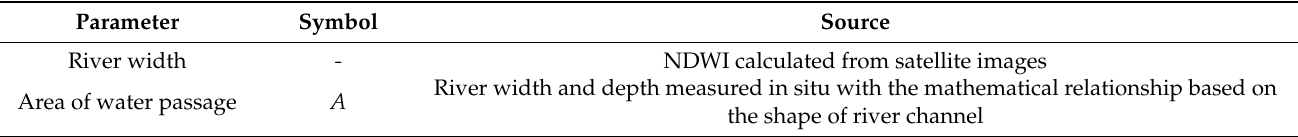
Table 2. The parameter used in RSHS and their sources. Parameter Symbol Source River width - NDWI calculated from satellite images River width and depth measured in situ with the mathematical relationship based on Area of water passage A the shape of river